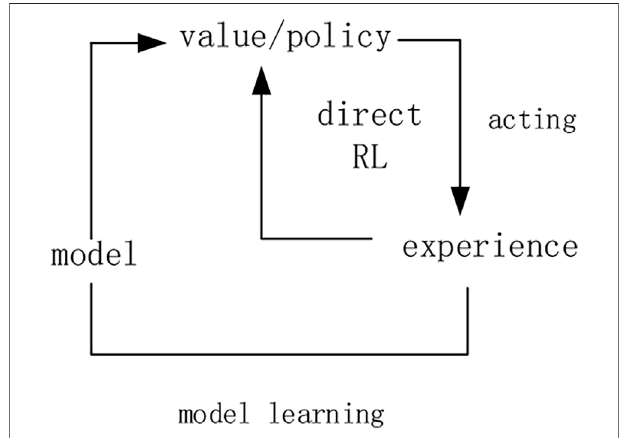
FIGURE1| SchematicdiagramoftheDynastructure(Tongetal.,2018).